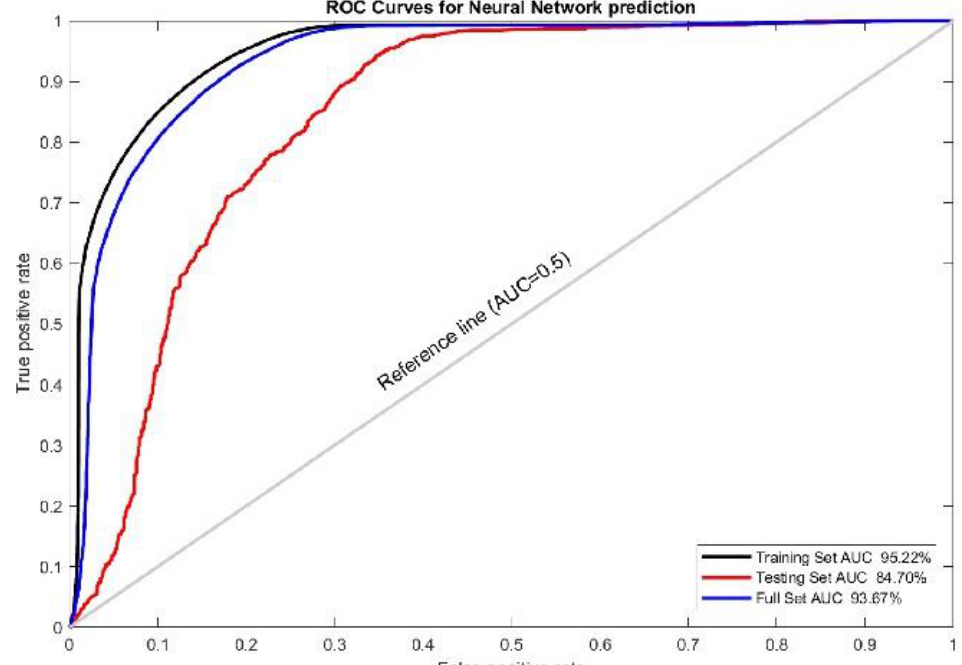
Figure 7 Performance accuracy of FFNN predictor based on Receiver Operating Characteristic (ROC) curves. ROC describe the performance accuracy through area under